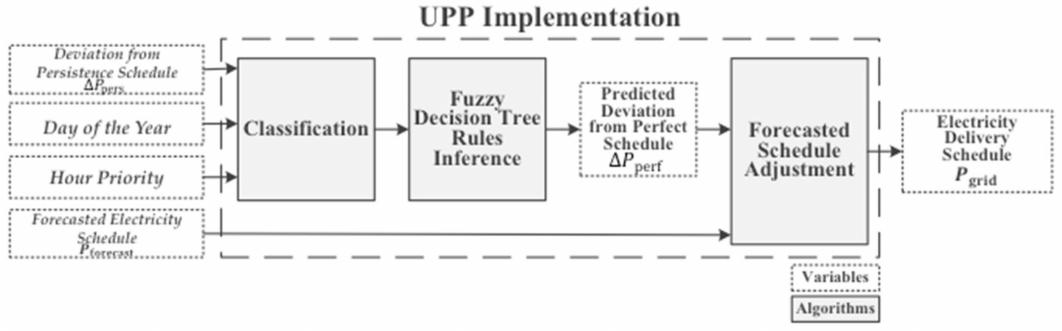
Figure 7. Uncertainty post-processing (UPP) implementation scheme.